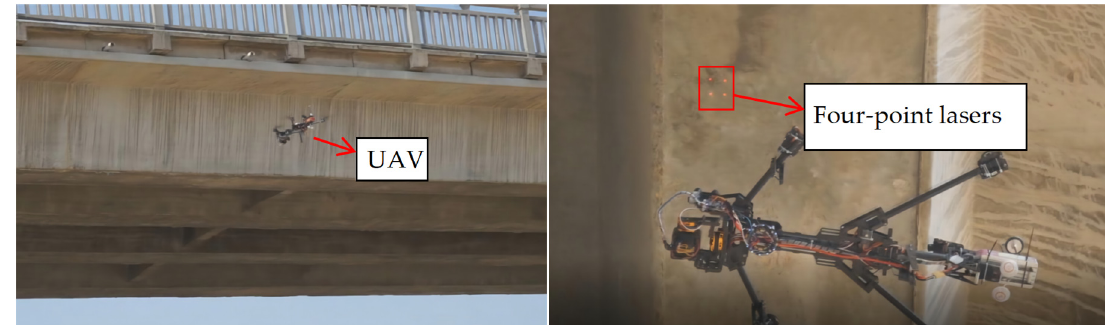
Figure 10. Crack inspection of the Beiwang Bridge.